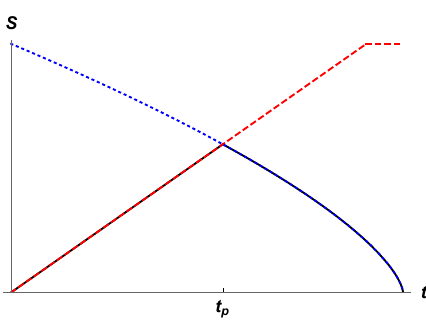
Figure 1 . The Page curves of the black hole and the radiation. At t = 0 , the black hole consists of the whole system and is in a pure state. The dotted line is the semi-classical entropy of the black hole from its horizon area. The dashed line is the entropy of the semi-classical radiation from Hawking’s calculation. The solid curve is the entanglement entropy for the black hole and the radiation in a full quantum description. It should be seen as two curves, one for the black hole and one for the radiation, which coincide as required by unitarity. The Page time t p refers to time scale where the solid curve turns around from increasing to decreasing with